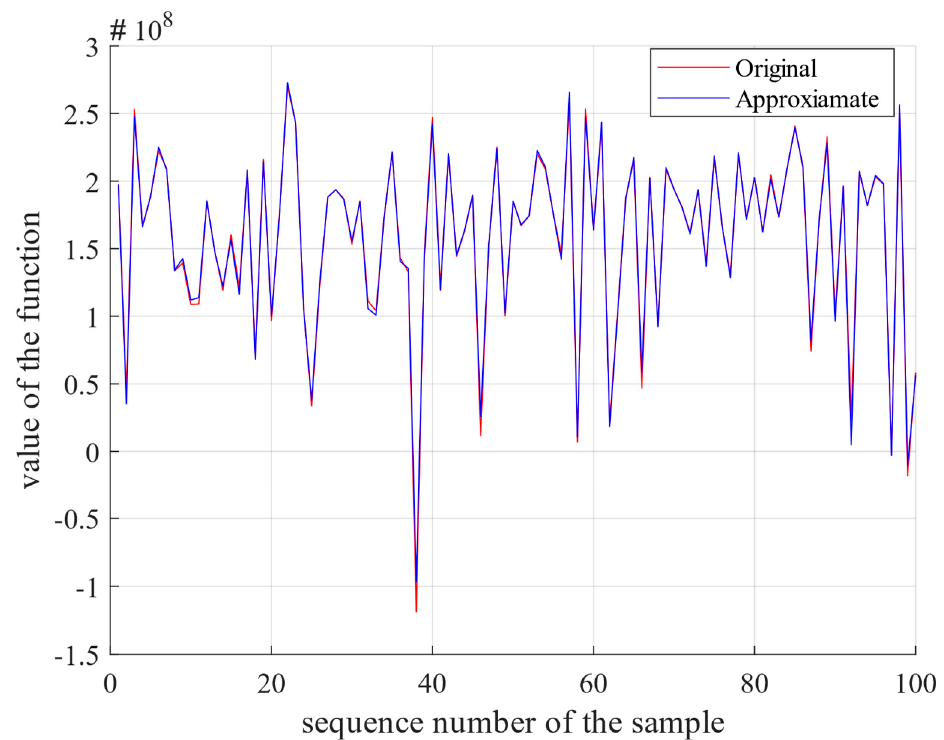
Figure 5. Comparison between the original function and the approximation obtained by the pro- posed method.